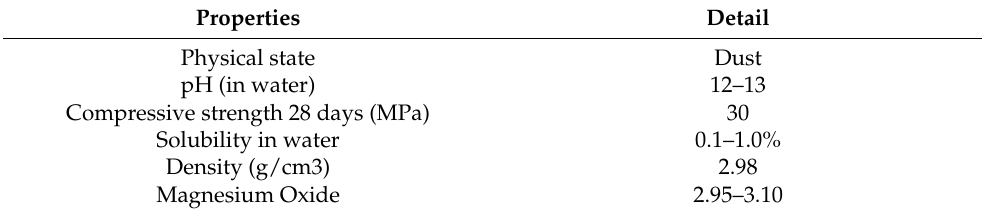
Table 2. Physical and Chemical Properties of HOLCIM Cement.